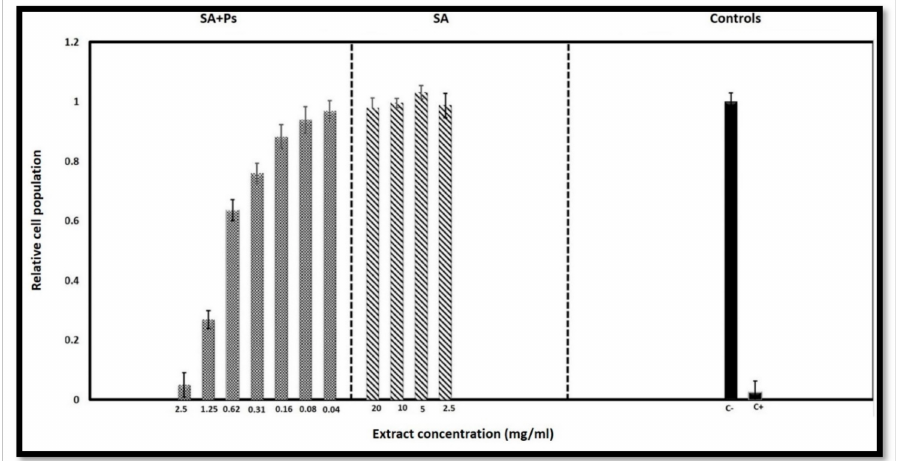
Figure 7. Results of the cytotoxicity test: cell populations calculated relative to the negative control show that extracts obtained with the SA sca ff olds are non-cytotoxic for the concentrations tested and extracts obtained with the Ps-containing sca ff olds are severely cytotoxic for concentrations of 1.25 mg / mL and above but become non-cytotoxic at concentrations of 0.08 mg / mL and